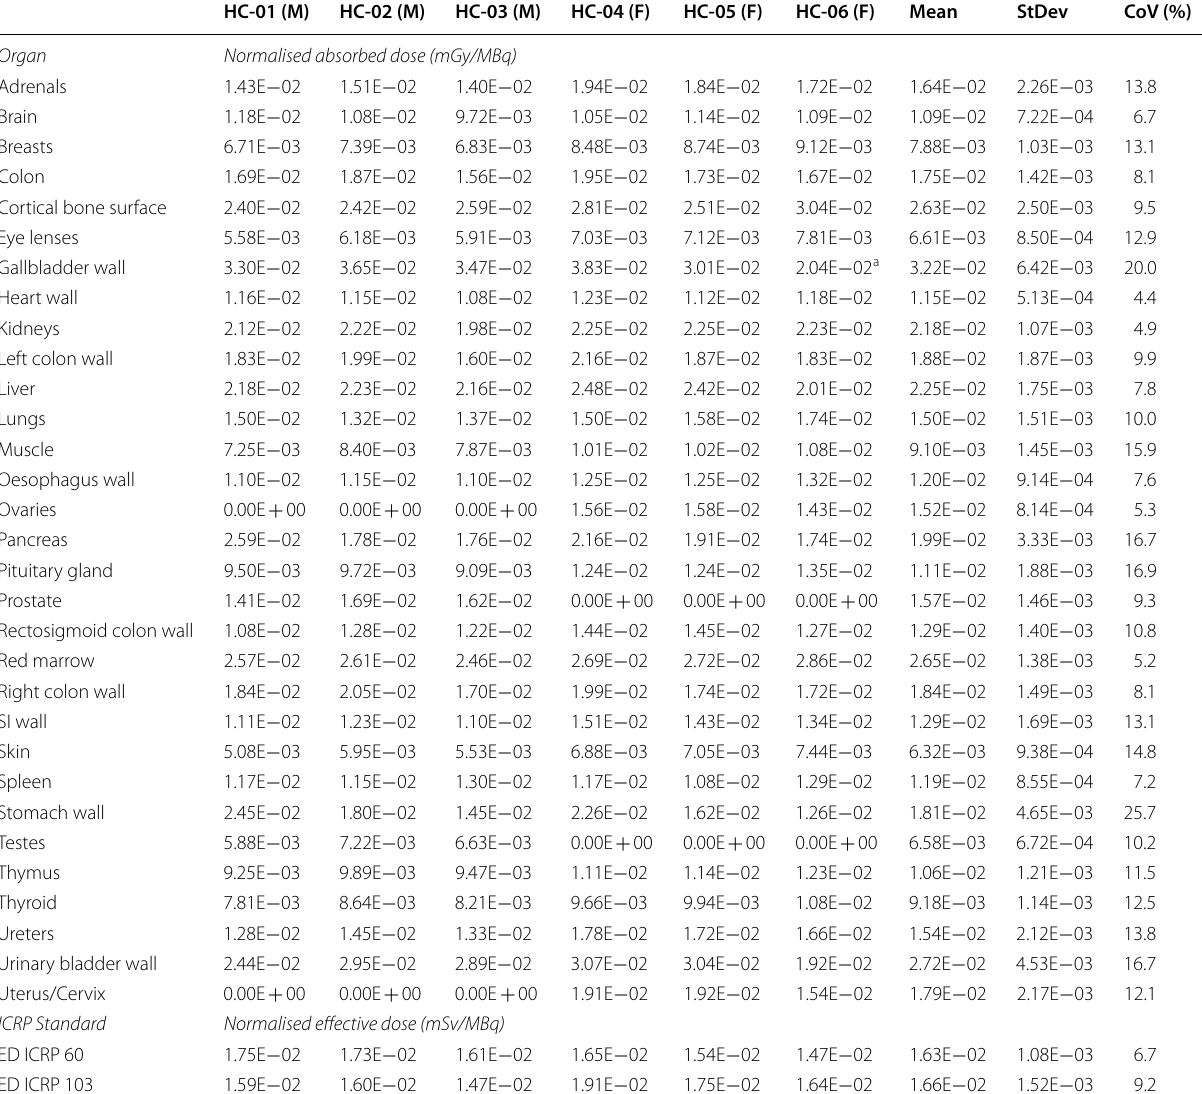
Table 3 Normalized absorbed doses and effective doses for [ 18 F]PR04.MZ for all subjects and selected target organs calculated with IDAC-Dose